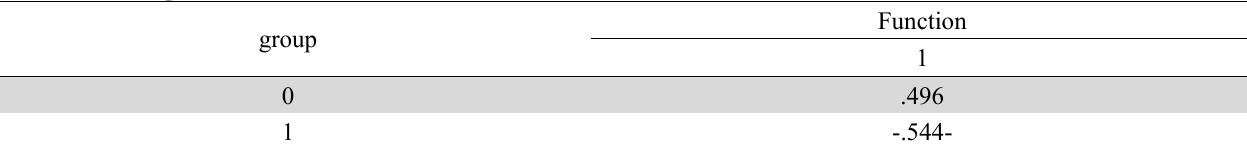
Functions at Group centroids